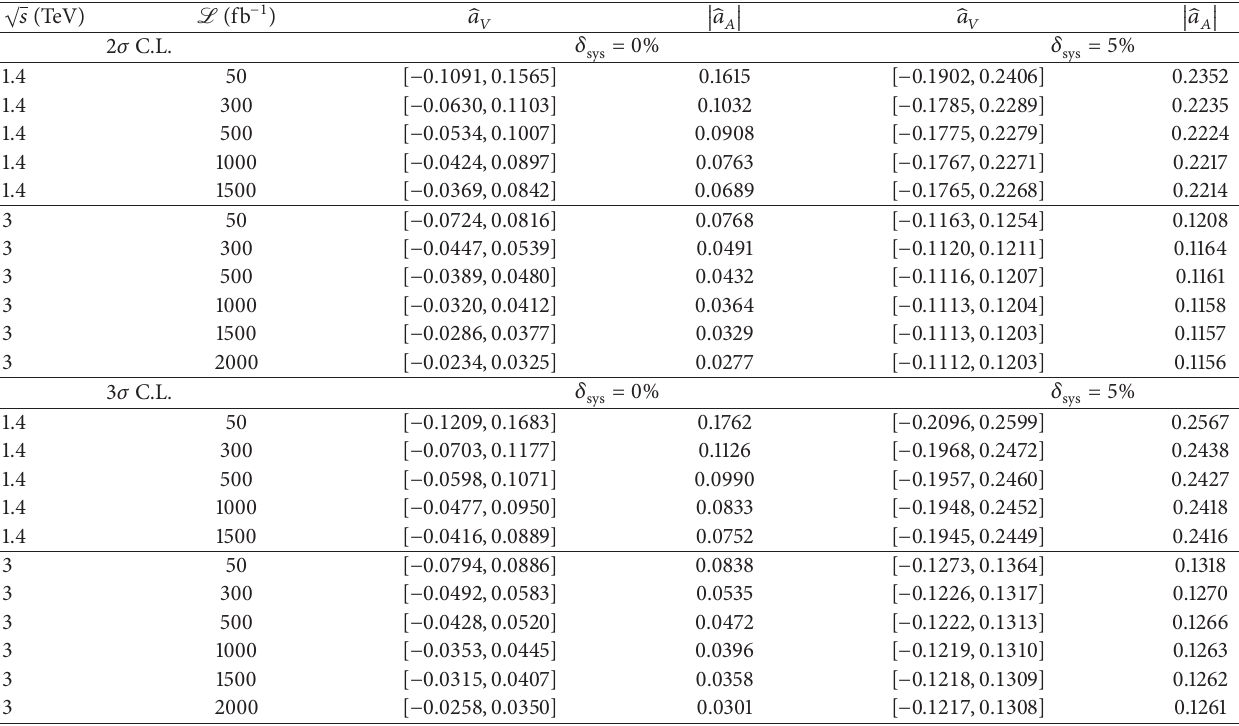
Table 1: Bounds on the ̂𝑎 𝑉 magnetic moment and ̂𝑎 𝐴 electric dipole moment for the process 𝛾𝑒 − → 𝑡𝑏 ] 𝑒 ( 𝛾 is the Compton backscattering photon) for 𝑃 𝑒 − ,𝑒 + = −80 %, 0 %, 𝑏 -tagging efficiency = 0.8 , 𝛿 sys = 0 %, 5 % at 2𝜎 and 3𝜎 C.L.